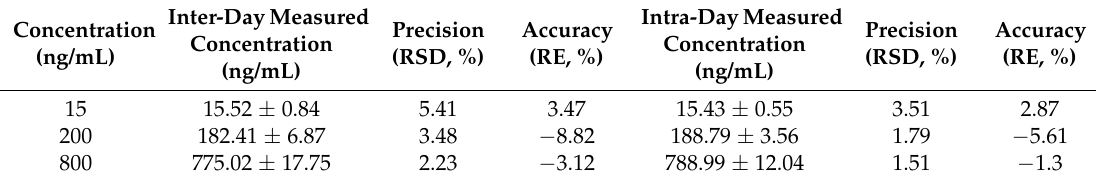
Table 1. Intra-day and inter-day precision and accuracy of RPDQ in rat plasma.